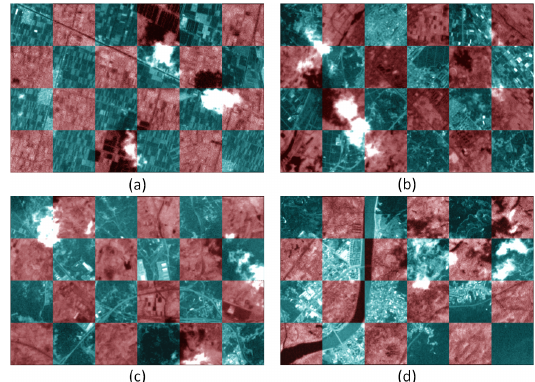
Figure 8. Comparison of the first band(marked blue) and the last band(marked red) in cloudy images using our framework.(a) is the farmland.(b) is the city.(c) is the road.(d) is the river.